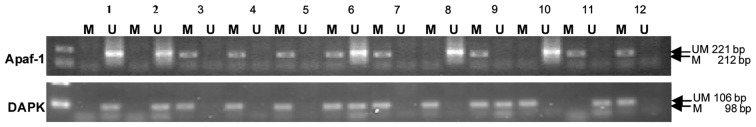
Representative examples of MSP analyses of Apaf-1 and DAPK. Lanes 1 and 2 show samples of normal oral mucosa. Lanes 3–12 show samples of OSCC. Lanes M show the amplified product with primers recognizing methylated sequences. Lanes U show the amplified product with primers recognizing unmethylated sequences. MSP, methylation-specific polymerase chain reaction (PCR); Apaf-1, apoptosis protease activating factor-1; DAPK, death-associated protein kinase; OSCC, oral squamous cell carcinoma; M, methylated; UM, unmethylated.